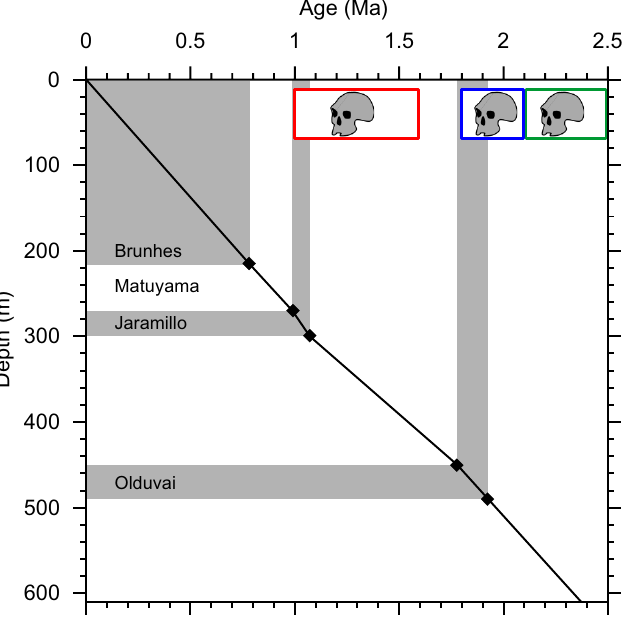
Figure 2. Time/depth curve of Acıgöl core, with paleomagnetic tie point in black, normal geomagnetic polarities in gray. Earliest hominin presence in Anatolia [4], Ciscaucasia [8], China plus Jordan [9, 10], is indicated in red, blue and green, respectively.